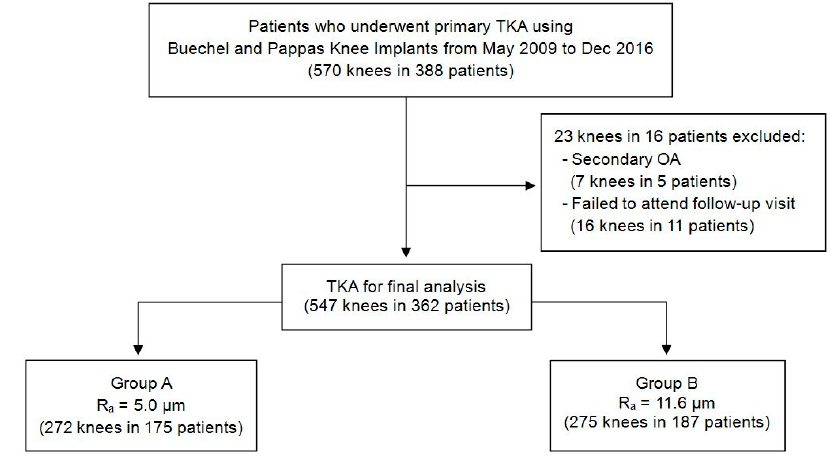
Figure 3. A flowchart of patient selection for this study (total knee arthroplasty (TKA), osteoarthritis